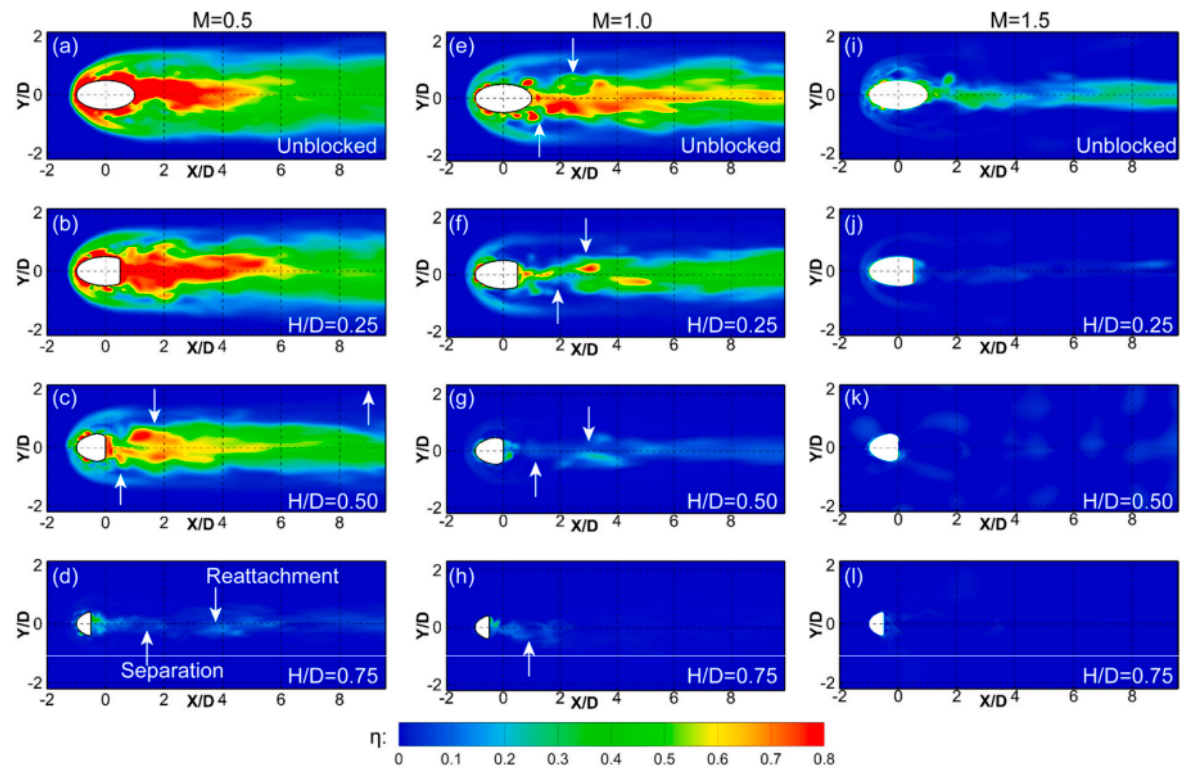
Figure 16. Film cooling effectiveness with different blockage levels [103] on flat surface. A reduction in film effectiveness happens with increased surface roughness [104]. The trend is captured in numerical simulations by Zamiri et al. [105].